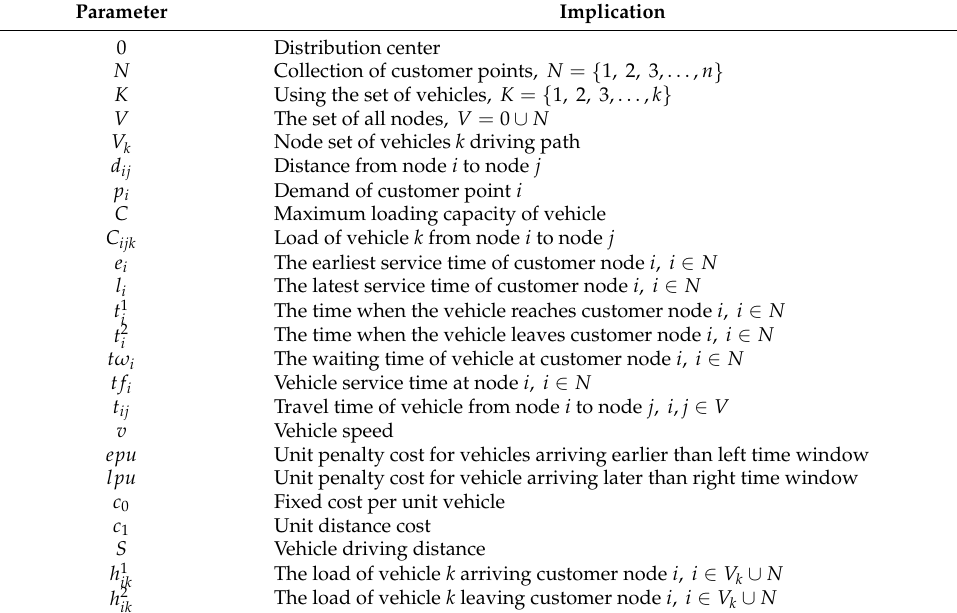
Table 3. The parameter